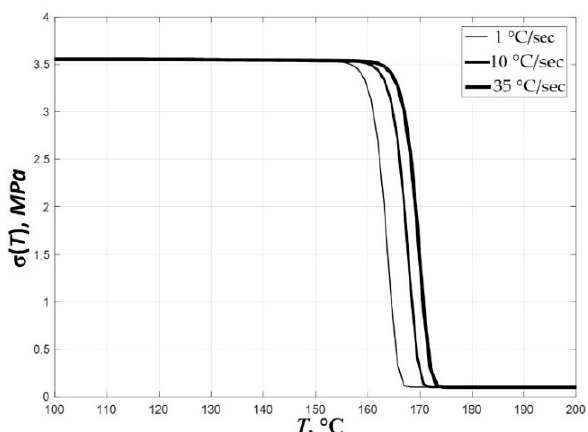
Figure 7. Curves of the temperature–time relaxation of a pinched PEEK sample without taking into account free deformation (calculation in